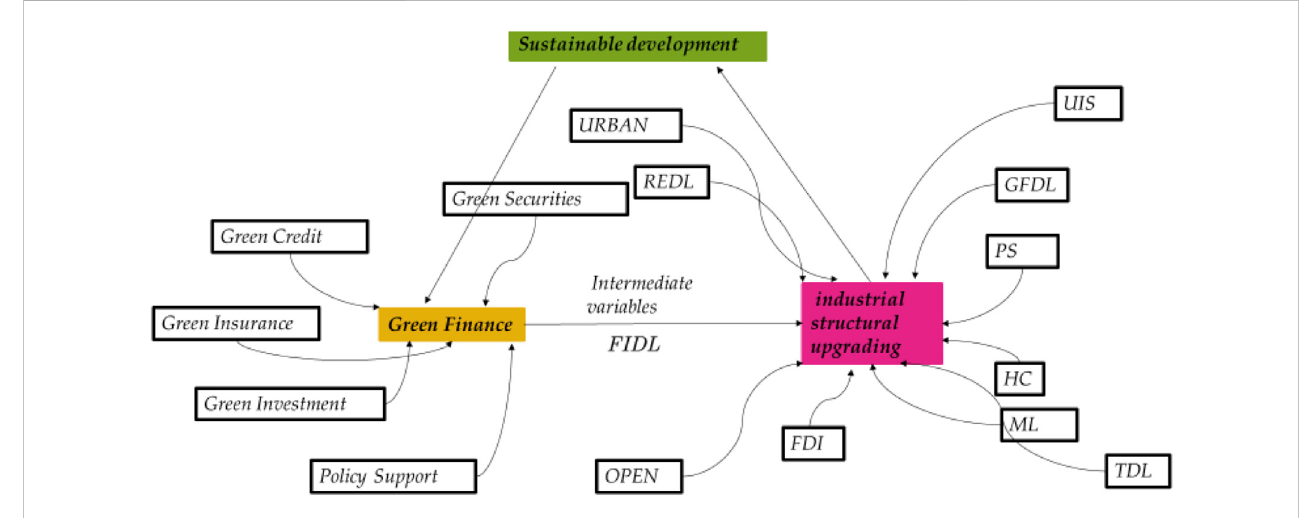
FIGURE 5 Theoretical Mechanism and research design.